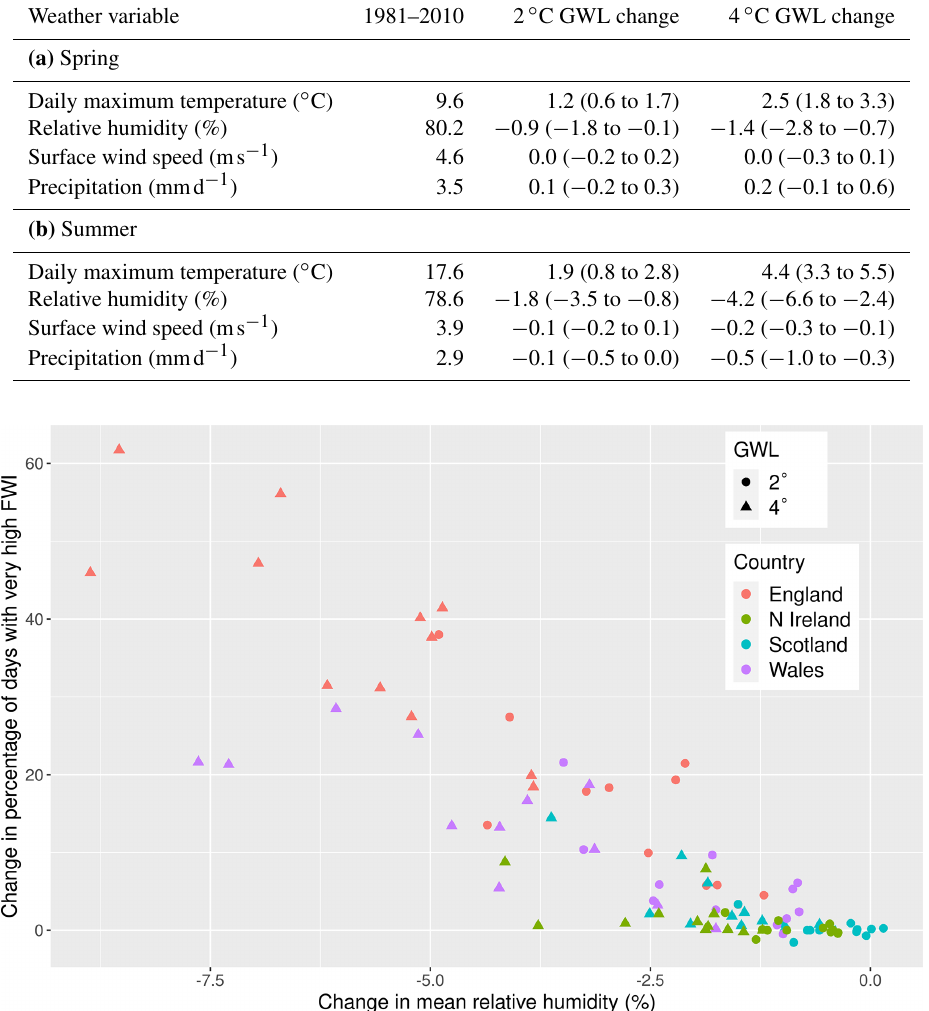
Table 3. Weather variables averaged over the UK for (a) spring and (b) summer; historical values for the 1981–2010 period and absolute changes from 1981–2010 to the 2 and 4 ◦ C global warming levels, showing the mean and range of 12 ensemble members from the UKCP18 12km model.